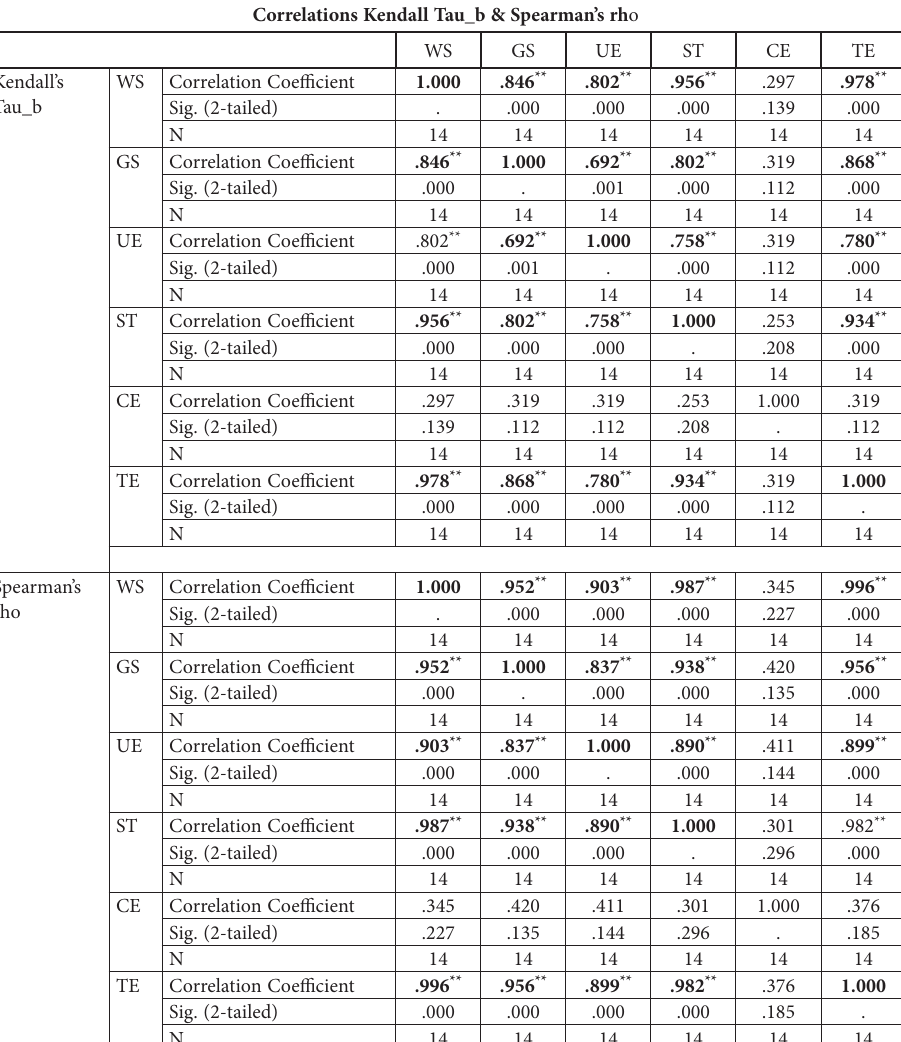
Table 11. Kendall_tau b & Spearman’s rho Correlation (WS, GS, UE, ST, CE, and